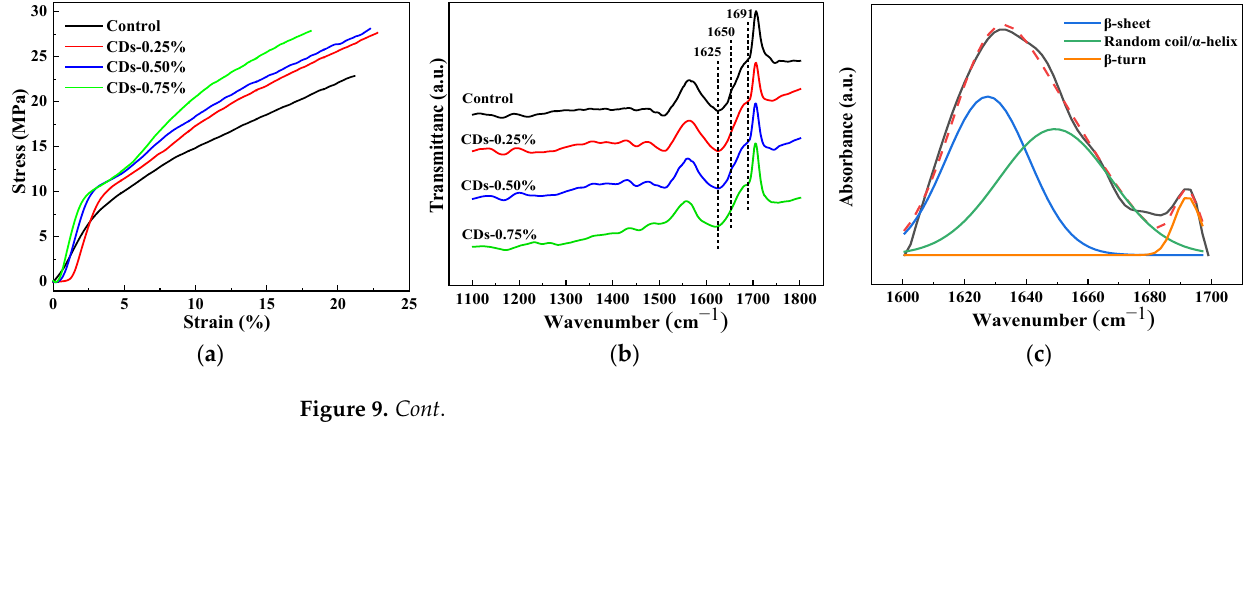
Figure 8. Effect of CDs on the fluorescent intensity of silk fibroin fiber. ( a – d ) Confocal laser microscopy images of silk fibroin fiber (measured with an excitation wavelength of 405 nm); ( e ) PL spectra of silk fibroin fiber (measured with an excitation wavelength of 370 nm).